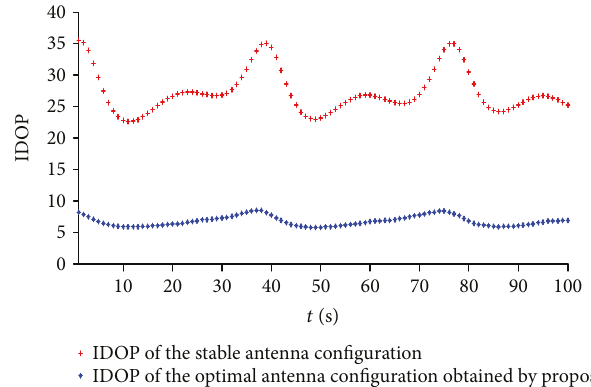
Figure 14: IDOP with the change of relative attitude of the intersatellite.